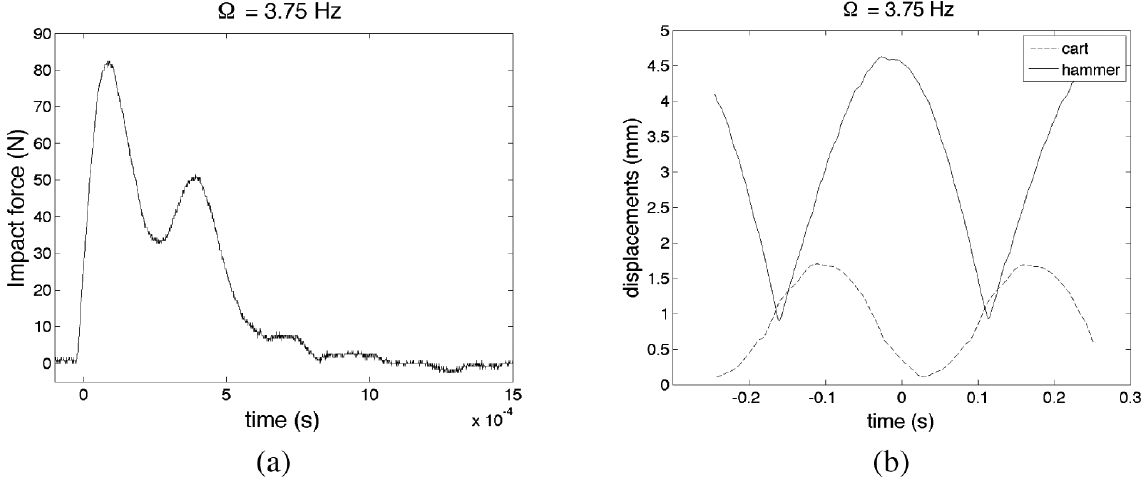
Fig. 4. Gap 0.0 mm. Excitation frequency 3.75 Hz: a) Impact force over time; b) Displacements (cart and hammer).